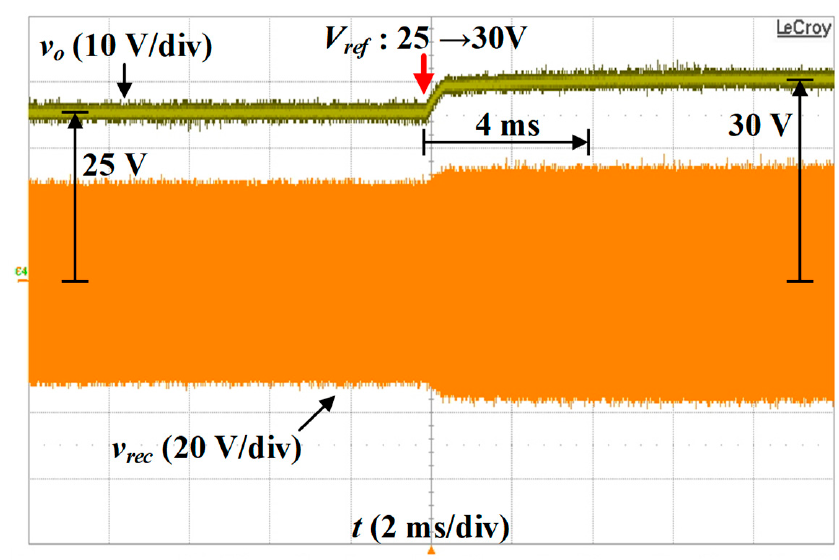
Figure 13. Step response when voltage reference is changed from 25 to 30 V at 100% load condition.